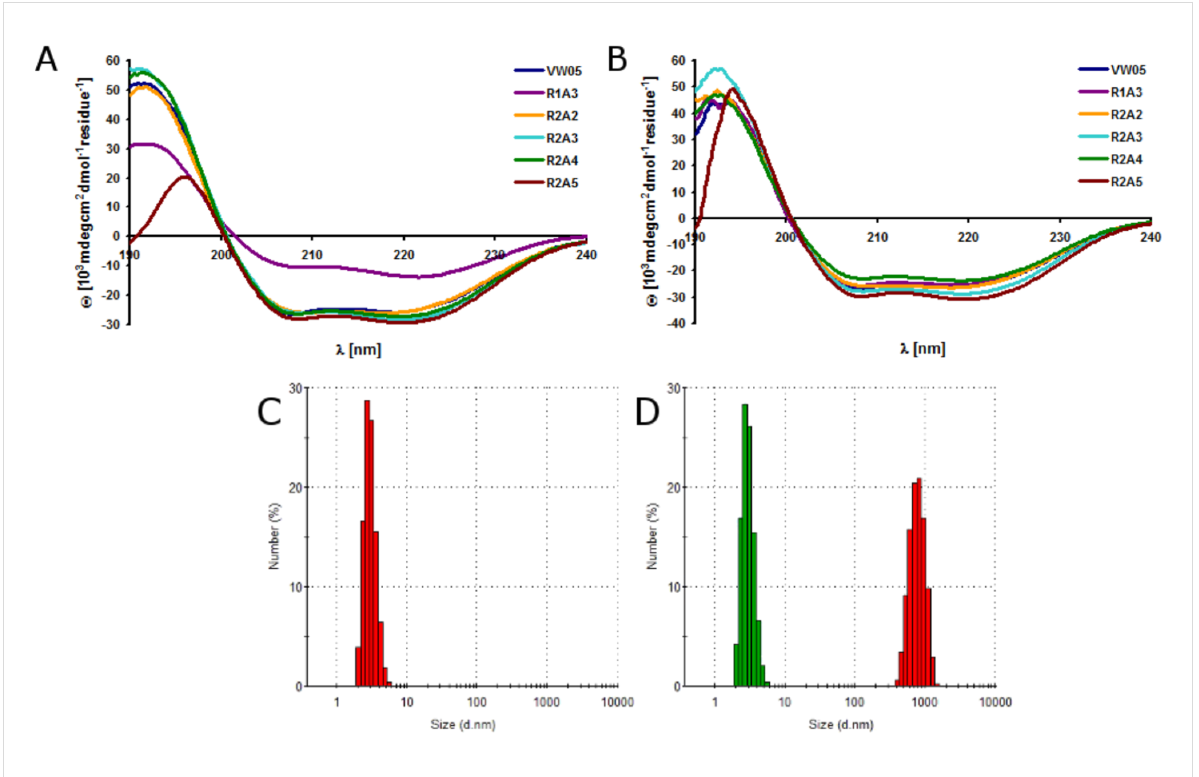
Figure 2: CD spectra of 30 µM peptide VW05, R1A3, R2A2, R2A3, R2A4 and R2A5 at (A) pH 9 and (B) pH 11 in 10 mM Tris/HCl buffer. Dynamic light scattering of (C) VW05 and (D) R2A2 both at 15 µM at (red) pH 9 and (green) pH 11. All measurements were carried out in 10 mM Tris/HCl